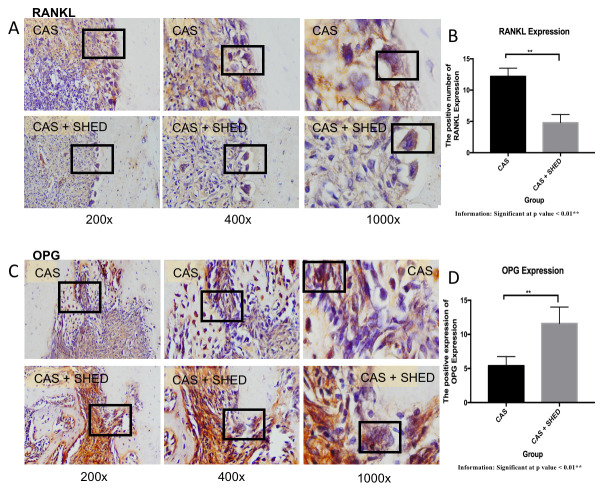
Histological sections of the Wistar rat’s (
R. Novergicus) afflicted periodontal tissues. Immunohistochemistry with antibody monoclonal (AbMo) and DAB were performed to examine the (
A) RUNX2 and (
B) ALP expressions. The positive cells were stained brown (black box) with 200x, 400x, and 1000x magnification using the light microscope. The number of osteoblasts expressing (
C) RUNX2 and (
D) ALP in the alveolar bone of the rats.